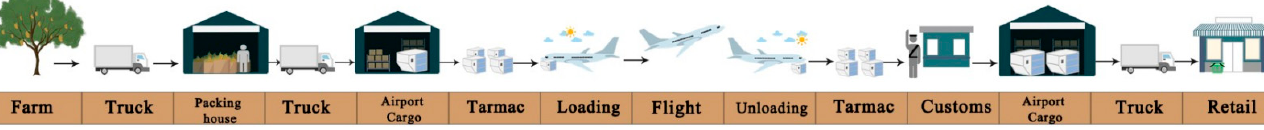
Figure 1. Flow diagram of transportation of mango fruits through the airport from the farm to the customers.